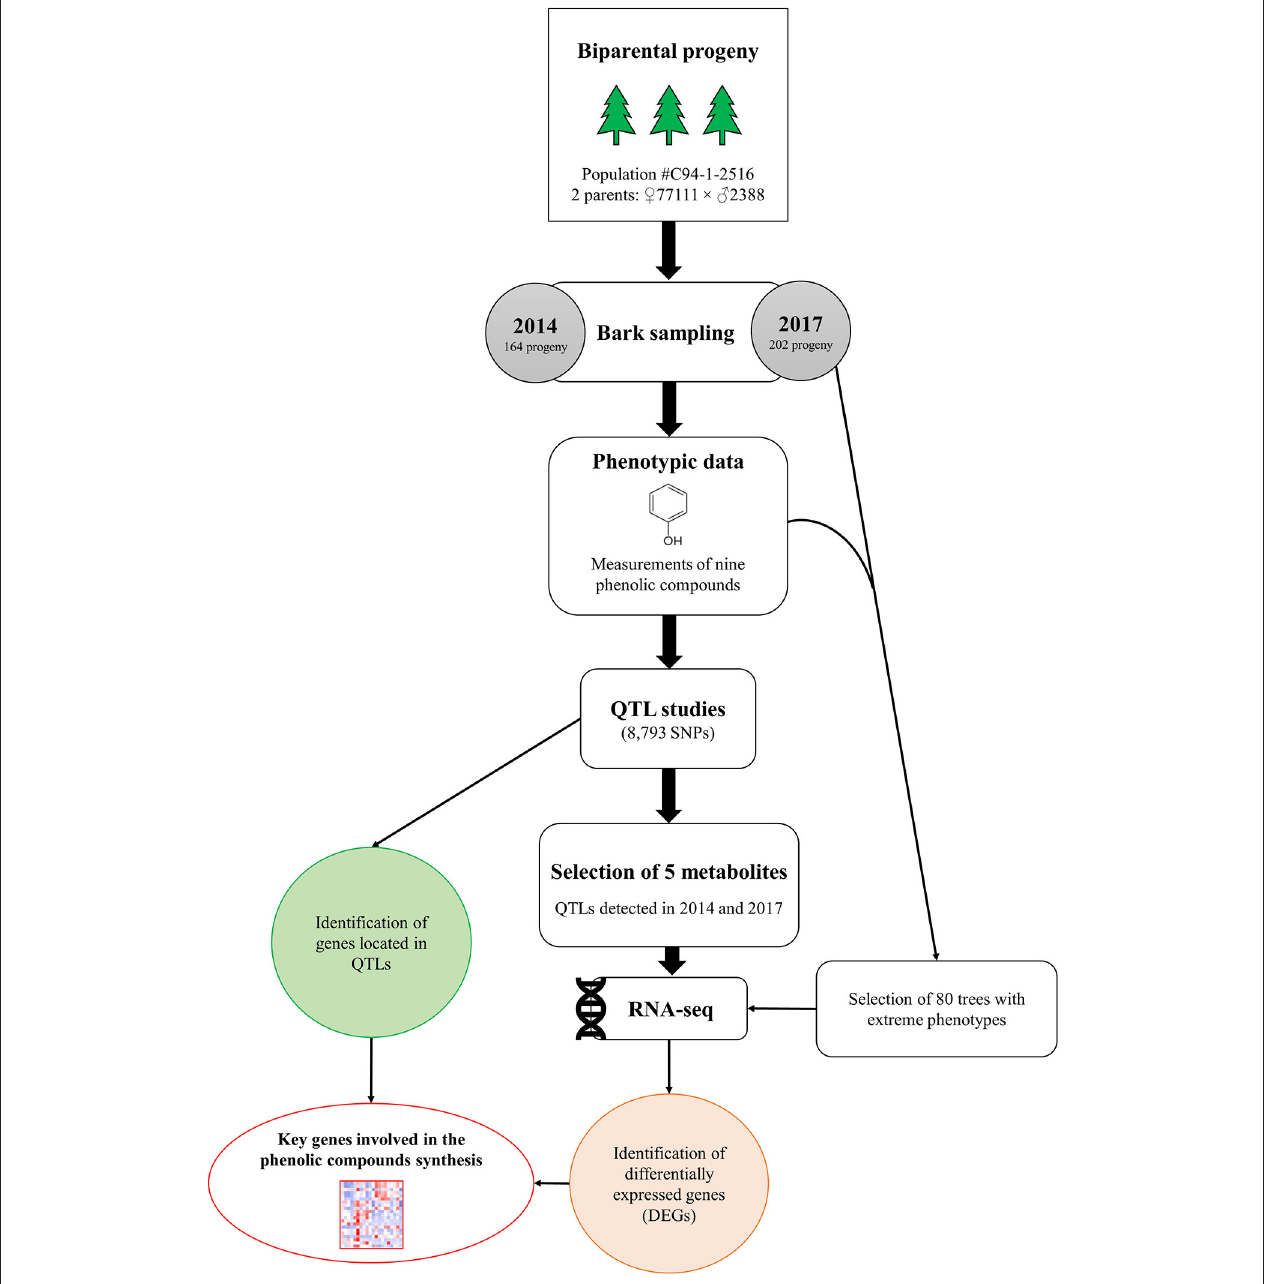
FIGURE 1 | Schematic representation of experimental design. Bark samples were collected from 164 to 202 white spruce siblings in 2014 and 2017, respectively. QTL analyses were performed on nine phenolic compounds for both years. For five metabolites, RNA sequencing was conducted on a subset of individuals displaying high vs. low metabolite contents in 2017. For each of the five metabolites, differentially expressed genes (DEGs) among groups of individuals displaying contrasting phenotypes were identified.